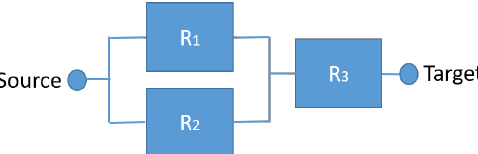
Figure 7. RBD organized in a hybrid configuration.